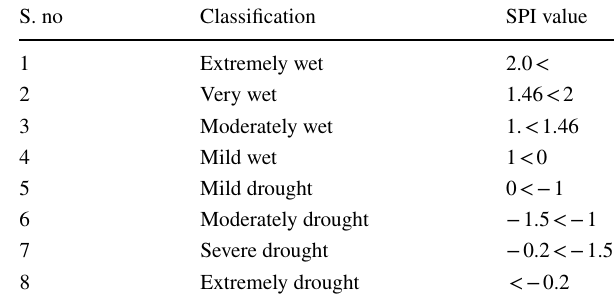
Table 6 Static water level in union councils of the study area Union council